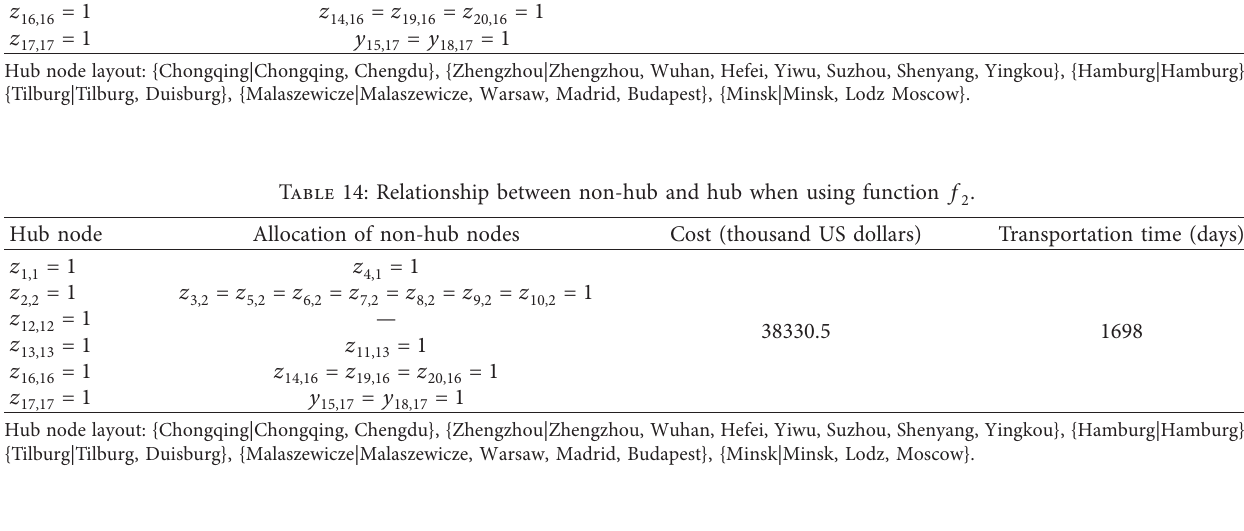
Table 15: Relationship between non-hub and hub when using function f